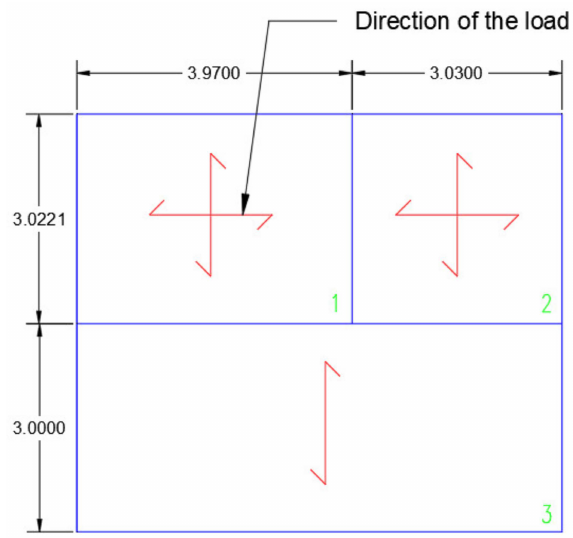
Figure 2. The direction of the load in the panels of slabs considered (loads in slabs 1 and 2 are both spread out in two directions, but are spread in one direction in slab